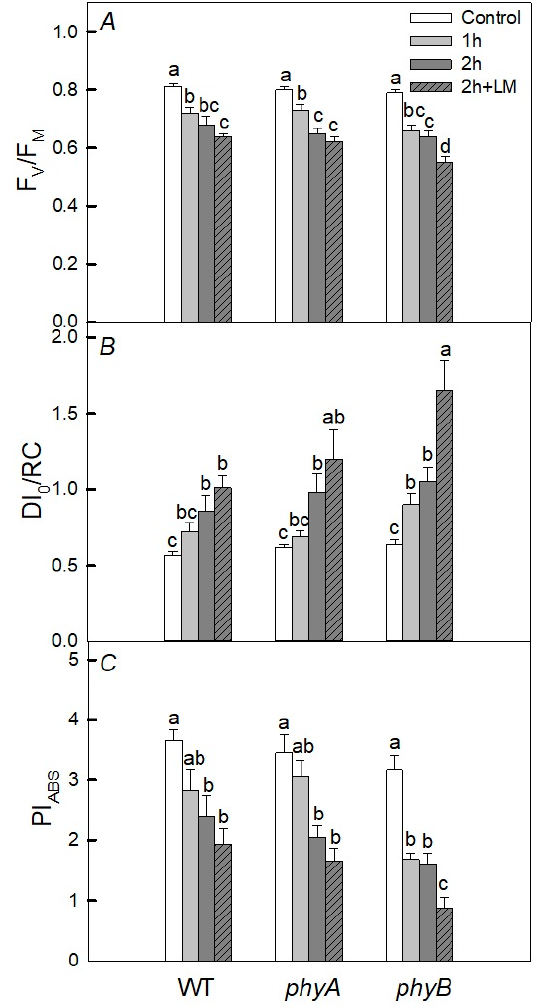
Figure 1. Effect of heat treatment on fluorescent parameters in 25-day wild type (WT) plants and phyA and phyB mutants grown under white fluorescent lamps (130 µ mol (photon) m − 2 · s − 1 , photoperiod 12 h) at a temperature during the photoperiod of 23 ◦ C and during the dark period of 21 ◦ C. The plants were taken out of the soil and kept in distilled water for 1 and 2 h at a temperature of 40 ◦ C under white LEDs (45 µ mol (photon) m − 2 · s − 1 ); some plants were kept in the solution of lincomycin (LM). Mean values ± SD are shown ( n = 4). Different letters correspond to a significant difference in values at p < 0.05. Here, F v /F m is the maximal quantum yield of PSII photochemistry ( A ), DI 0 /RC is the quantum yield of energy dissipation ( B ), and PI ABS is the PSII performance index ( C ).